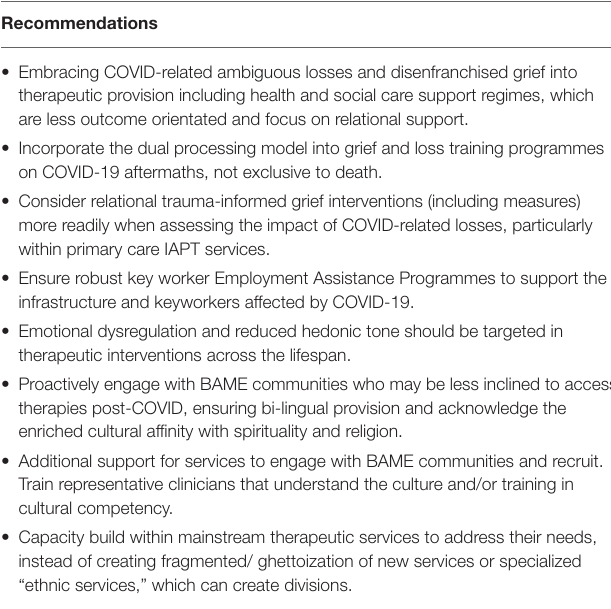
TABLE 1 | Recommendations—responding to COVID losses.